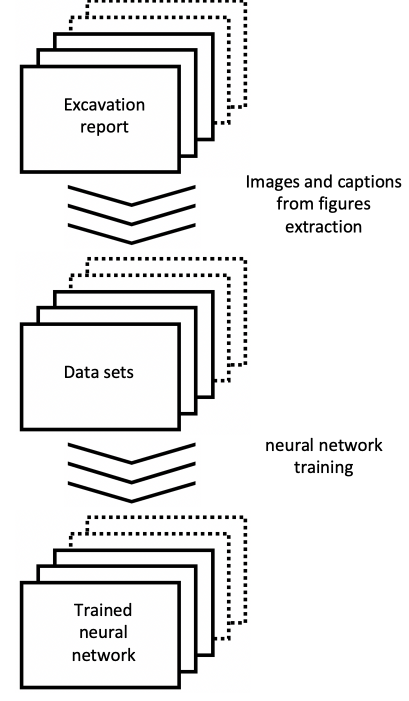
Figure 3 Diagram of the presented study